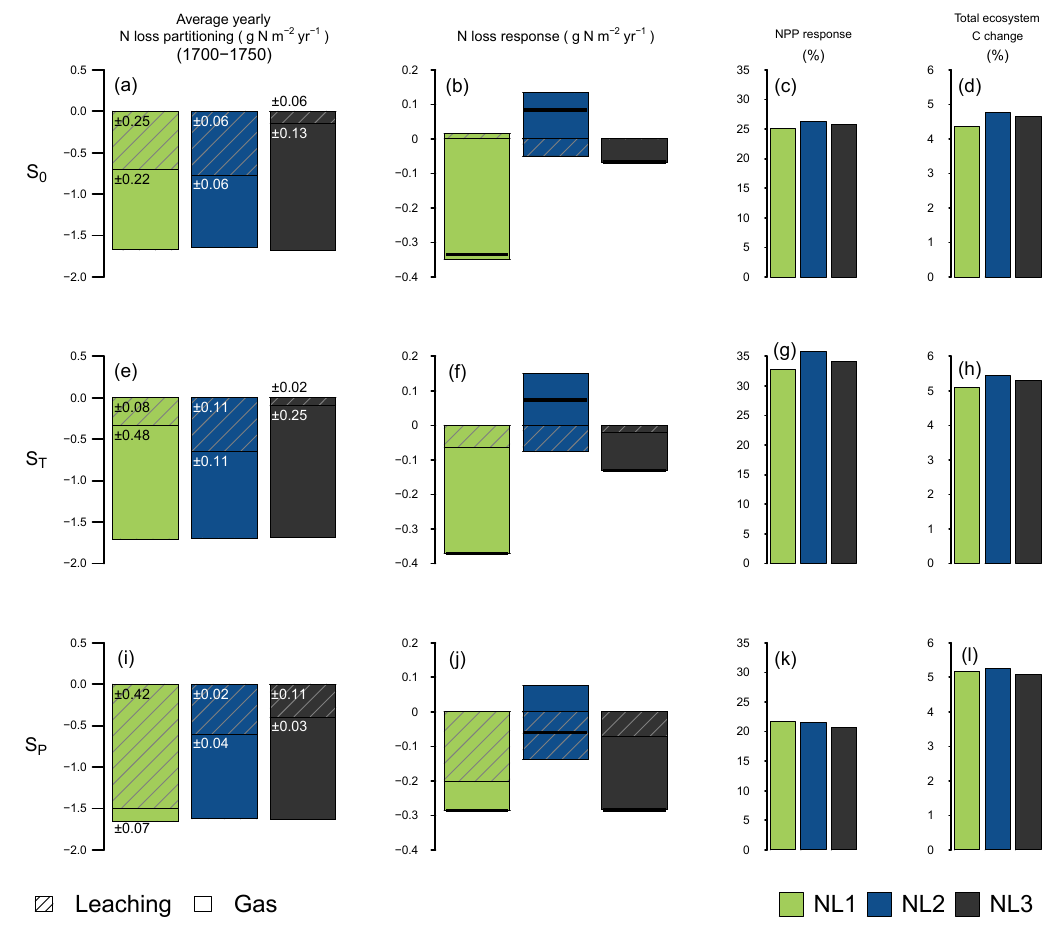
Figure 2. Average fate of ecosystem nitrogen (N) input at the three pseudosites “ S 0 ”, “ S T ”, and “ S P ” for the 1700–1750 quasi-equilibrium simulation period without perturbation ( a, e, i ; gNm − 2 yr − 1 ). Average N loss rate responses (gNm − 2 yr − 1 ) to 10 years of simulated elevated atmospheric CO 2 (eCO 2 , + 200ppm) (b, f, j) . Net primary productivity (NPP) responses (%) after 10 years of eCO 2 , relative to control simulations (c, g, k) . Change (%) in total ecosystem carbon (C) after 10 years of eCO 2 , relative to the start of the experiment (d, h, l) . Colours indicate the applied N loss algorithm (NL1, NL2, NL3). For (a) , (b) , (e) , (f) , (i) , and (j) , shading lines indicate leaching, and unshaded colour indicates gaseous loss. Numbers on the bars indicate the standard deviation (gNm − 2 yr − 1 ) of the leaching and gas loss components over the 1700–1750 quasi-equilibrium period. For (a) , (e) , and (i) , the sums of N allocation to organic pools (vegetation biomass and soil organic matter) were in the range of − 0.07 to 0.01gNm − 2 yr − 1 and were omitted here. External inputs of reactive N